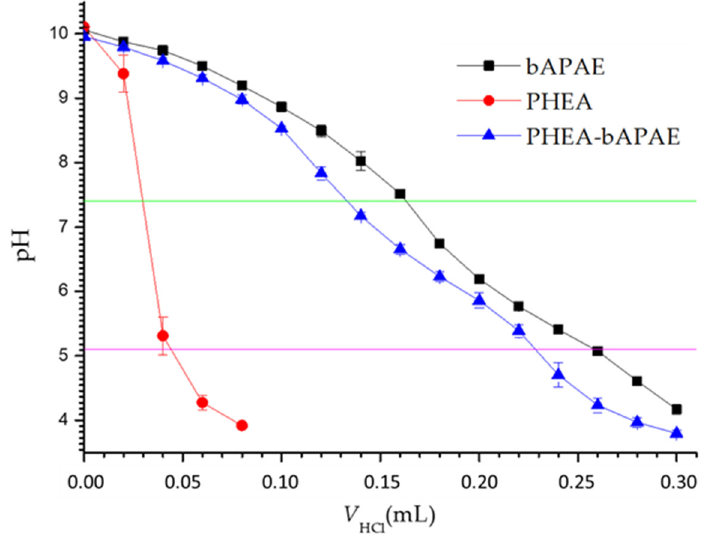
Figure 3. Acid–base titration profiles (pH versus acid volume) of PHEA ‐ g ‐ bAPAE (0.2 mg/mL) graft copolymer, PHEA (0.2 mg/mL) and bAPAE moieties (0.047 mg/mL).